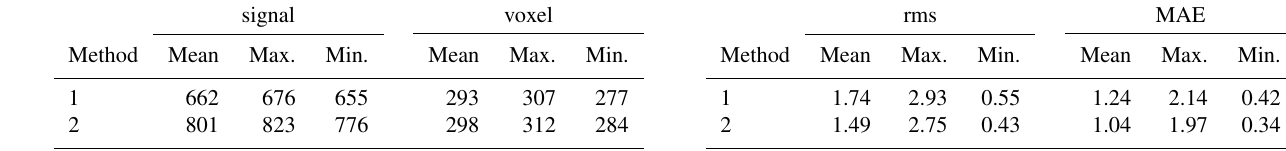
Table 1. Statistical result of the number of signals used and the Table 2. Statistical information on the tomographic result compared number of voxels crossed by rays for the experiment period. with radiosonde data for the experimental period. signal voxel rms Method Mean Max. Min. Mean Max.